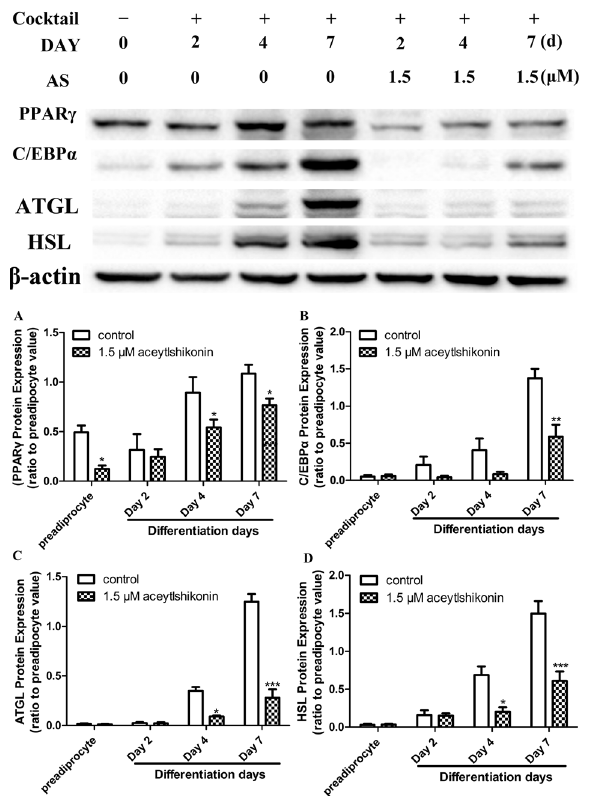
Fig 4. AS inhibits PPAR γ , C/EBP α , HSL, and ATGL expression in adipocytes. Protein levels were assessed by western blotting in 3T3-L1 cells cultured for 0, 2, 4, and 7 days in the presence or absence of 1.5 μ M AS during adipogenesis. Immunoblots are representative of five independent experiments; β -actin served as a loading control. * P < 0.05, ** P < 0.01, *** P < 0.001 vs. untreated adipocytes at the same time point.